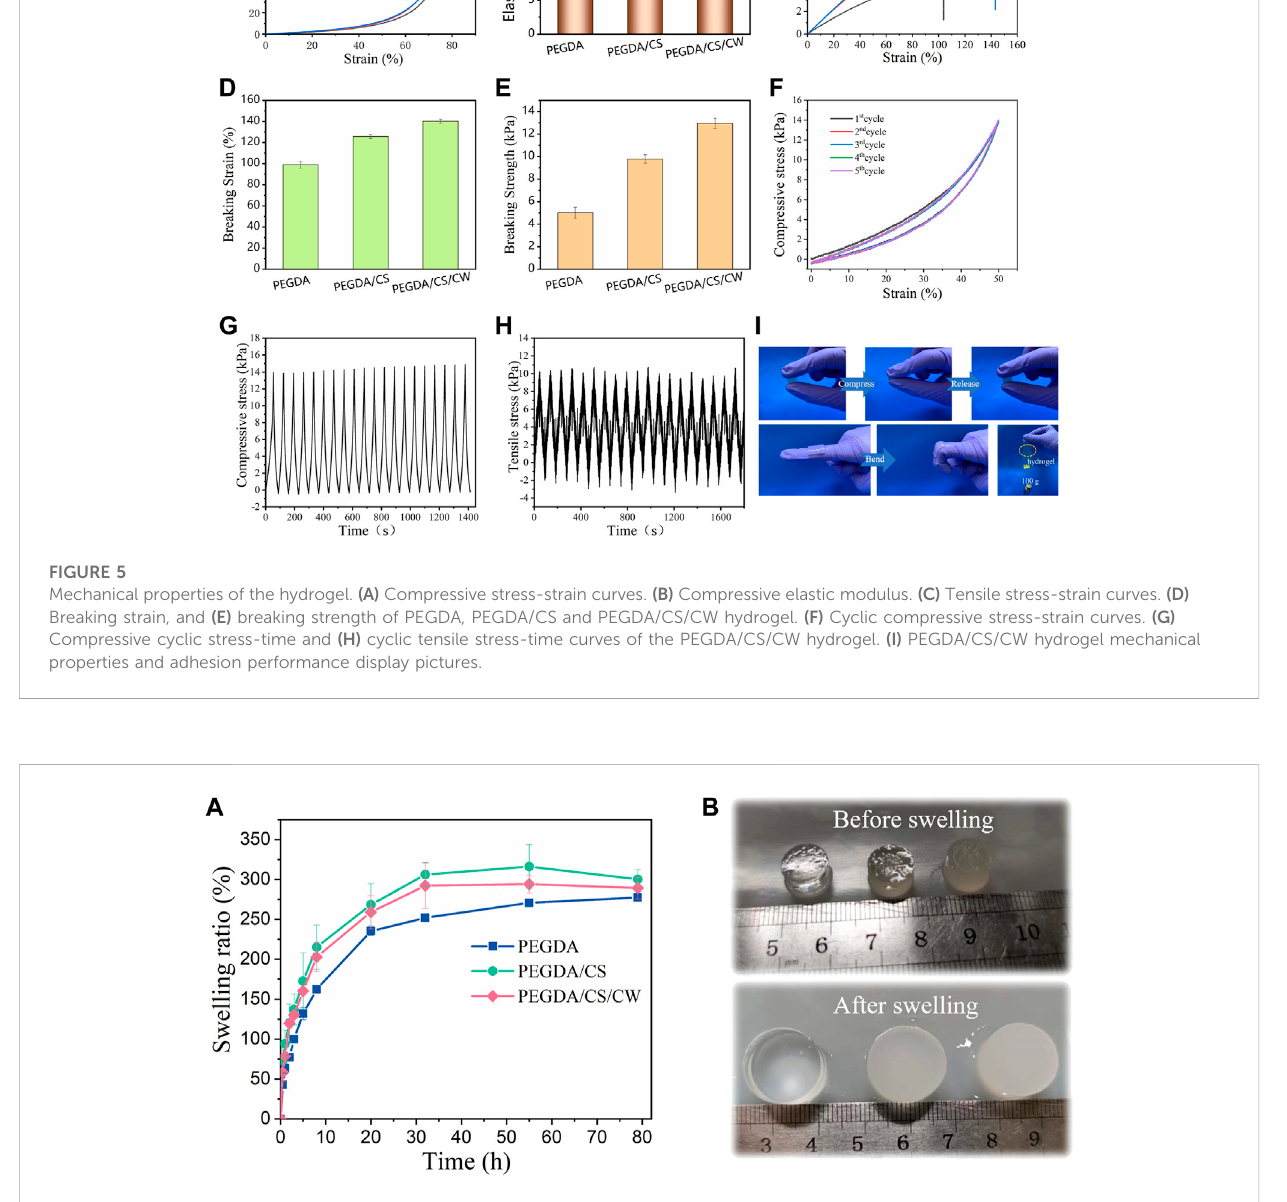
FIGURE 6 (A) Swelling rate of hydrogel. (B) Before and after pictures of hydrogel